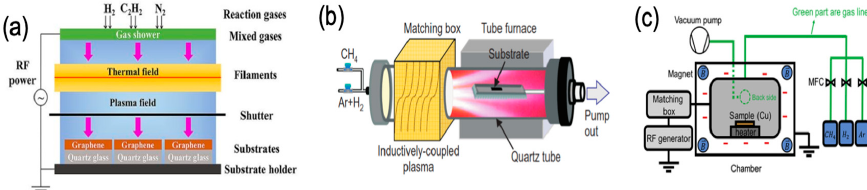
Figure 13. A schematic of the RF-PECVD setup accompanied with ( a ) hot filament [106], ( b ) ICP [107] and ( c ) CCP (reprinted with permission from